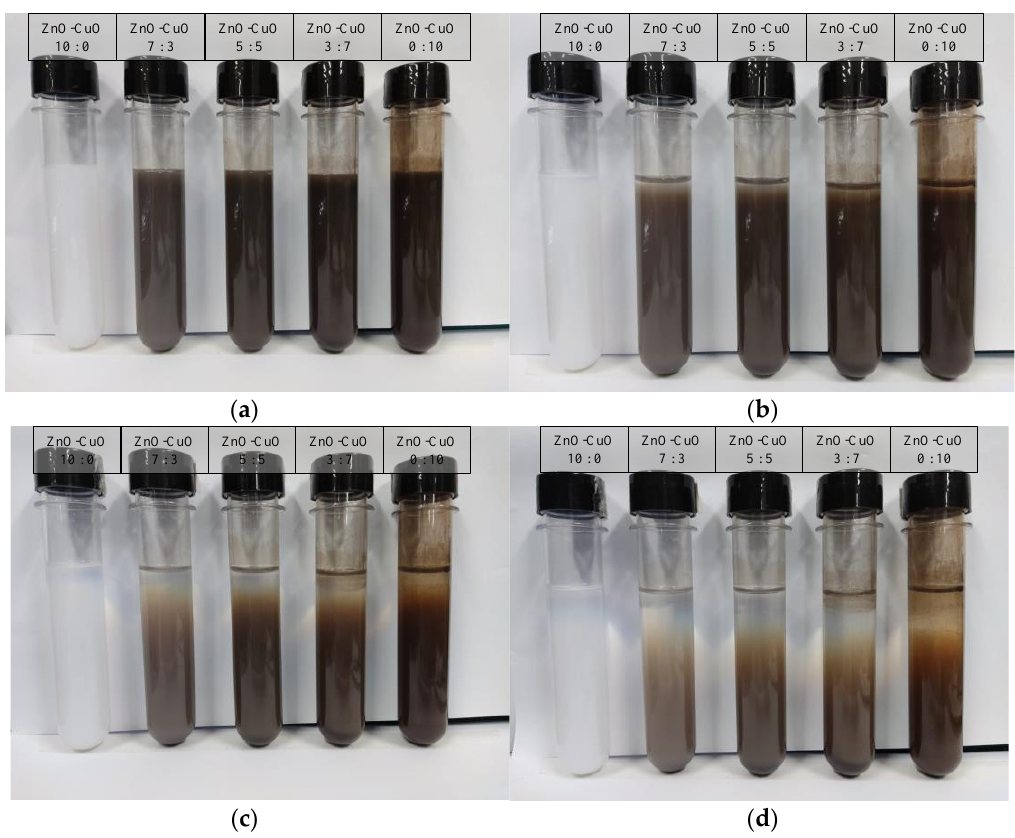
Figure 8. Visual observation on the sedimentation for different mixing ratio of ZnO-CuO/water hybrid nanofluids without surfactant-SDBS at ( a ) 24 h, ( b ) 48 h, ( c ) 72 h, and ( d ) 96 h.